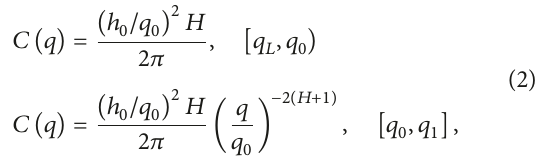
From Figure 2, the Hurst exponents for AC, SMA, and OGFC are 0.53, 0.62, and 0.65, and the corresponding fractal dimensions are 2.47, 2.38, and 2.35. and temperatures of a carbon and silica reinforced rubber compound used for the tire was measured using dynamic shear rheometer. Then a generalized Maxwell model with n terms was applied to describe the complex modulus of the rubber. Williams-Landel-Ferry (WLF) function was used and the master curve of viscoelastic modulus was obtained in Figure 3. The imaginary part of viscoelastic modulus depicted the energy dissipation when rubber is sliding on the oscillating surface